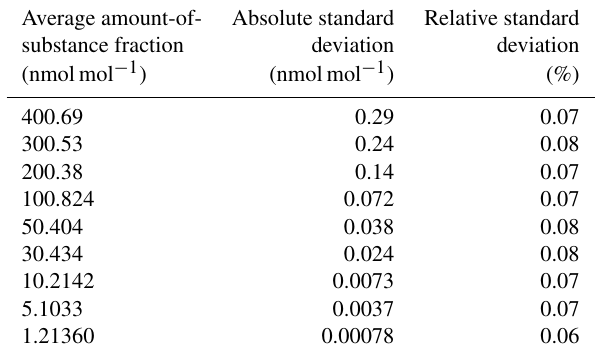
Table 4. Repeatability of amount-of-substance fractions generated by the ammonia reference generator. The average and the absolute and relative standard deviations of the amount-of-substance frac- tions generated during the last 30min are